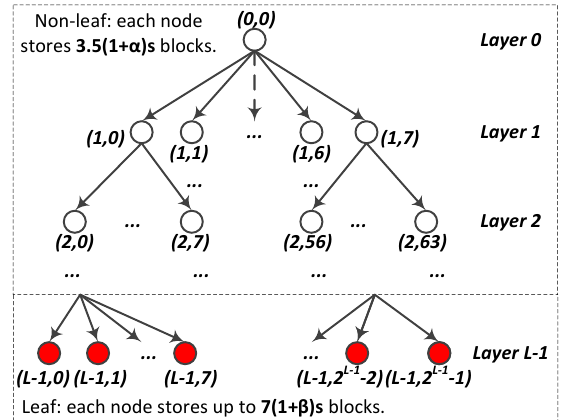
Figure 2. Server Storage